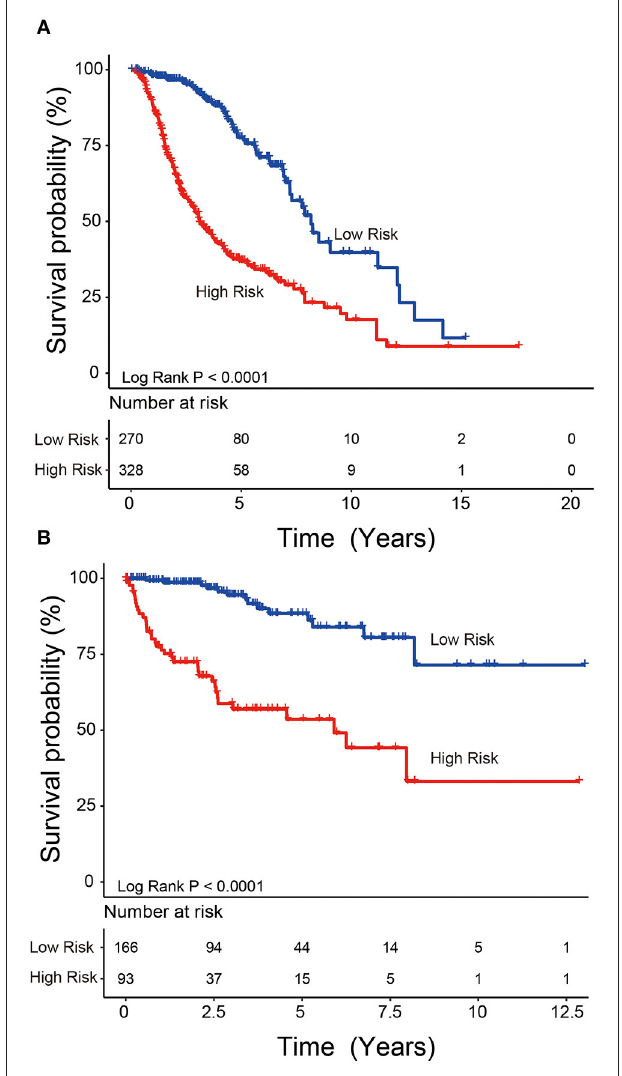
FIGURE 5 | Radiotherapy stratification analysis. The five-PCG signature could further divide patients with radiotherapy (A) or patients without radiotherapy (B) into two groups with significantly different